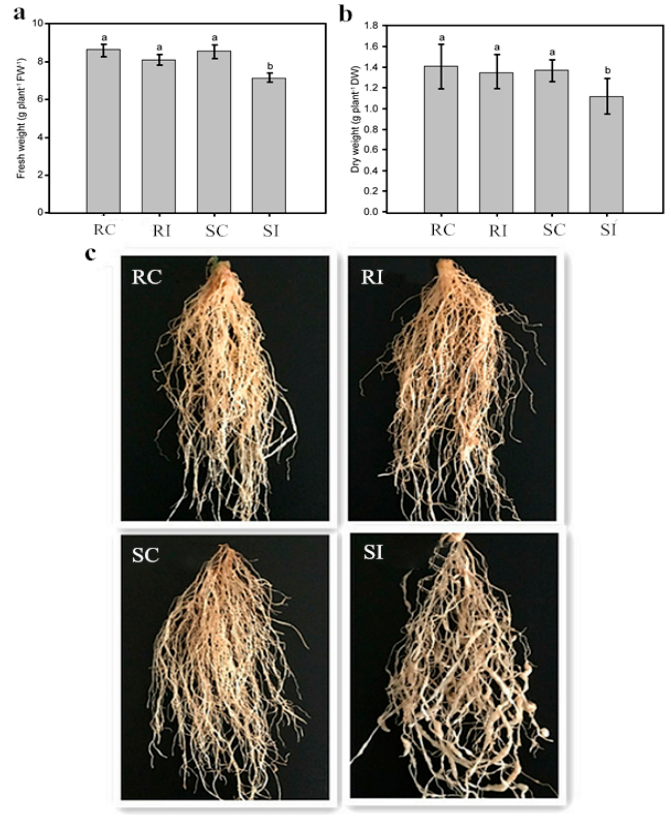
Figure 1. Phenotypic traits of K326 and Changbohuang. ( a ) Fresh weight. ( b ) Dry weight. ( c ) Symptoms of nematode infection. Notes: Means followed by the small letters are significantly different at 0.05 levels, respectively.